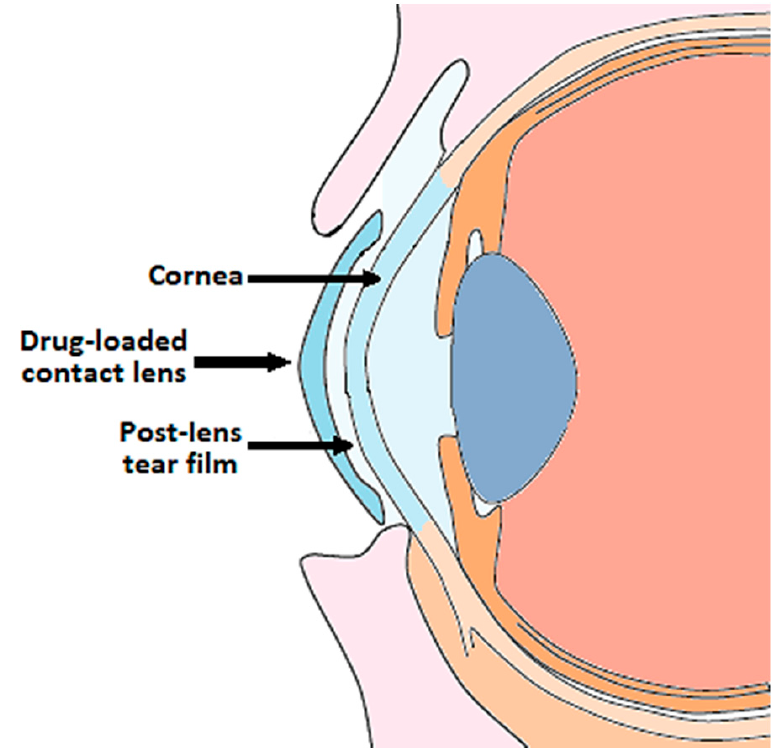
Figure 1. Ophthalmic drug delivery from contact